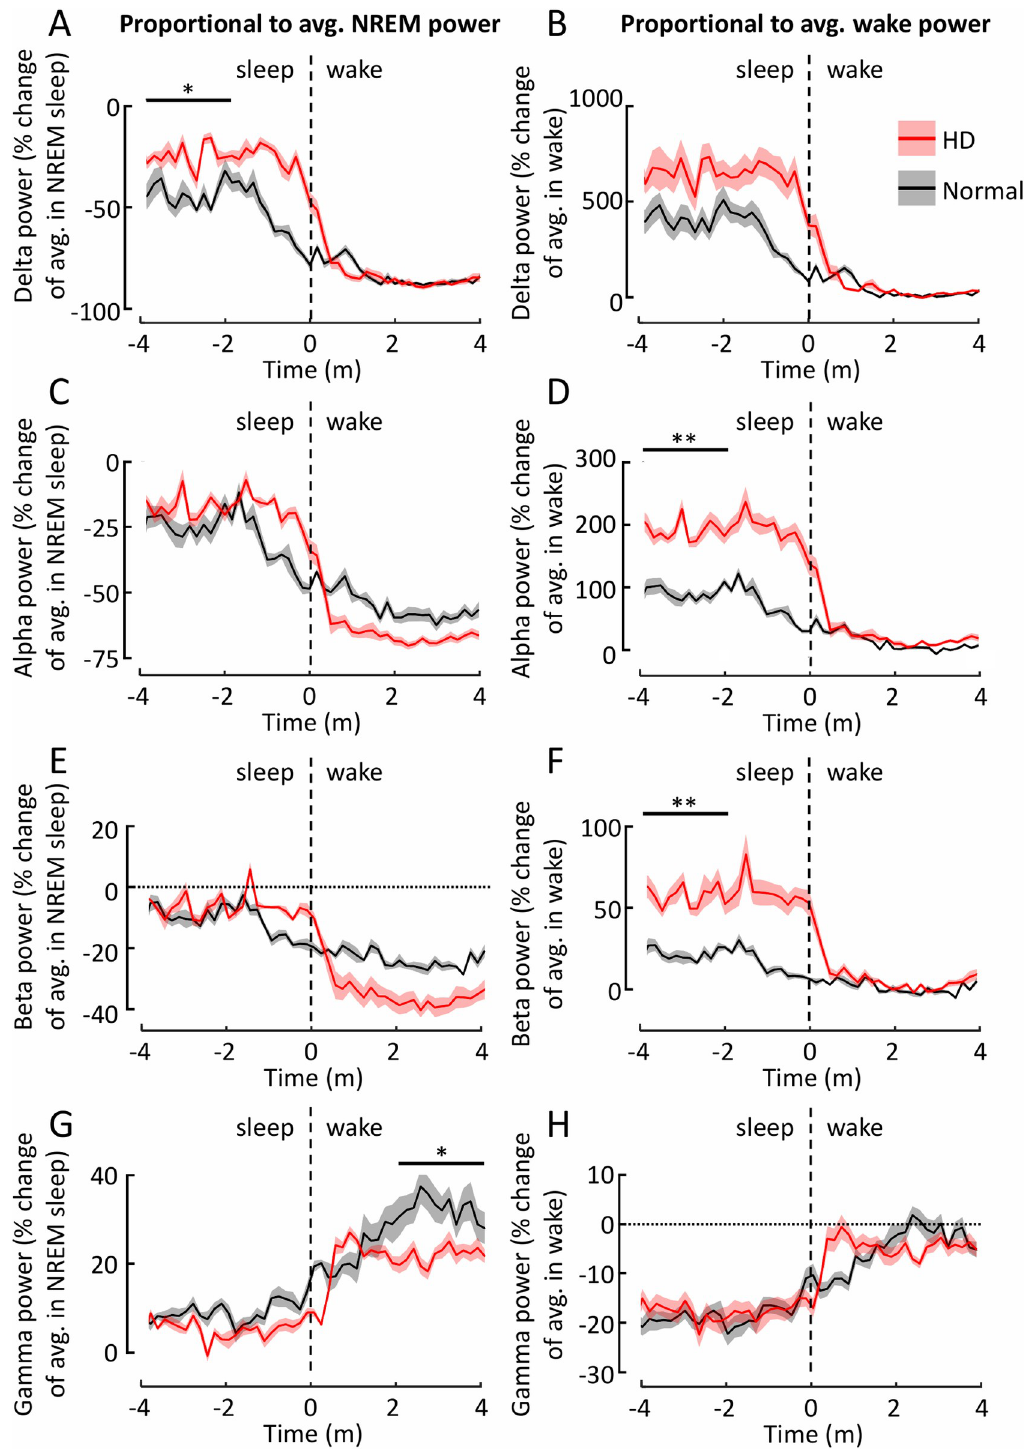
Fig 4. Changes in power during transitions from sleep-to-wake are more extreme in Huntington’s disease than normal sheep. Power changes were calculated as the proportional change relative to the mean NREM sleep power ( A, C, E, G ) or wake power ( B, D, F, H ). Frequency ranges presented are delta ( A, B ), alpha ( C, D ), beta ( E, F ) and gamma ( G, H ). Each trace represents proportional power changes for a particular frequency band in the mean transitions to wake for all normal (black line) or HD (red line) sheep. The shading represents the standard error of the mean. For clarity data are shown for the Fr2-L